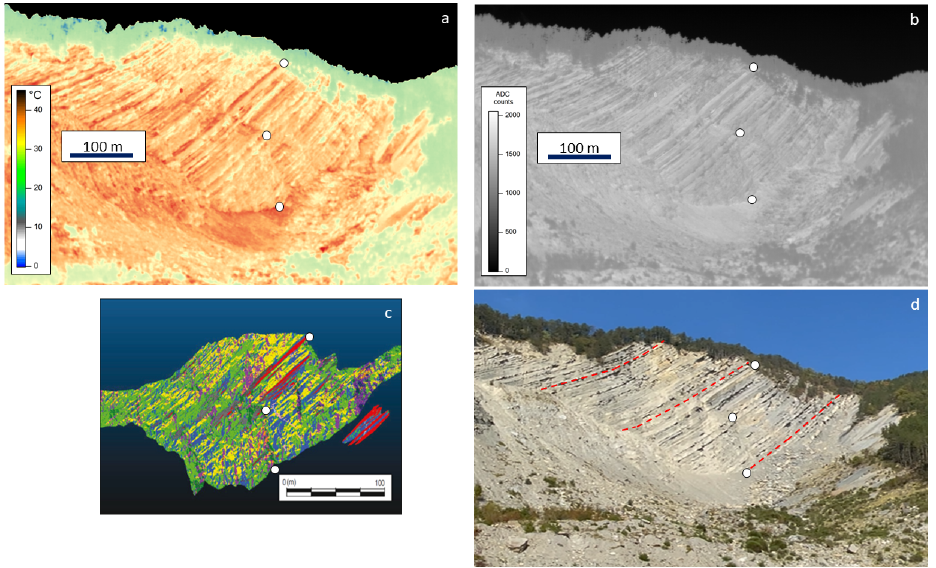
Figure 4. ( a ) Thermal image represented in the false-color temperature scale loaded in the camera software. The sky pixels have low values and have been manually set to black. ( b ) Thermal image in grayscale, corresponding to the raw image data in analog-to-digital-converter (ADC) counts. Note the stacking fault in the middle of the scarp, almost perpendicular to the strata, which is very clearly visible in the TIR images ( c ) point-cloud image of the same rocky scarp, obtained by stroboscopic imaging with an unmanned aerial vehicle (reproduced from Ref. [35]): the different colors highlight the discontinuity systems enclosed within rock joint lines, which may be taken to correspond to different homogeneous rocky areas (e.g., the stripes in red color represent the sandstone overhangs mentioned in the paper text). The angle of observation is slightly different in the thermal/visible image and in panel c, therefore we added three reference points to all panels (white dots). ( d ) visible image of the scarp showing the three different members of the marly-arenaceous formation separated by dashed red lines, according to